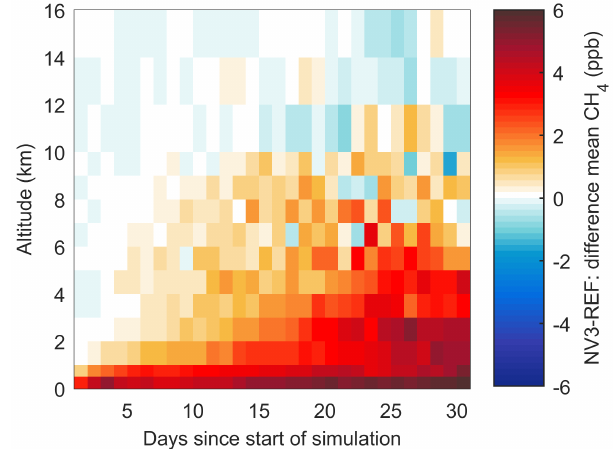
Figure 3. Difference in simulated regional mean methane (ppb) per altitude for FLEXPART CTM simulations NV3–REF in January 2013. The values are averages per altitude level for the region south of 60 ◦ S.